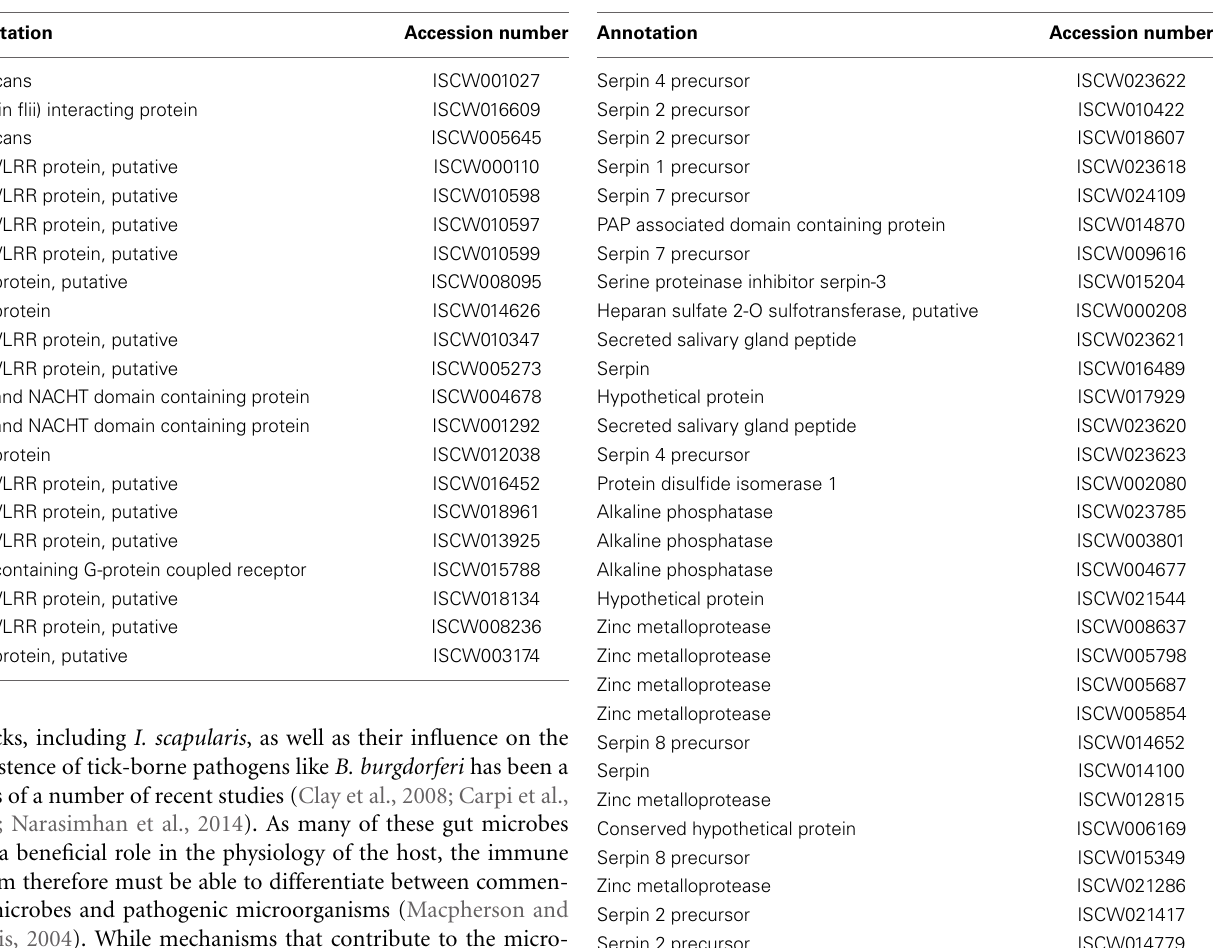
Table 3 | Leucine-rich repeat (LRR) proteins. Table 4 | Proteases/Protease inhibitors.